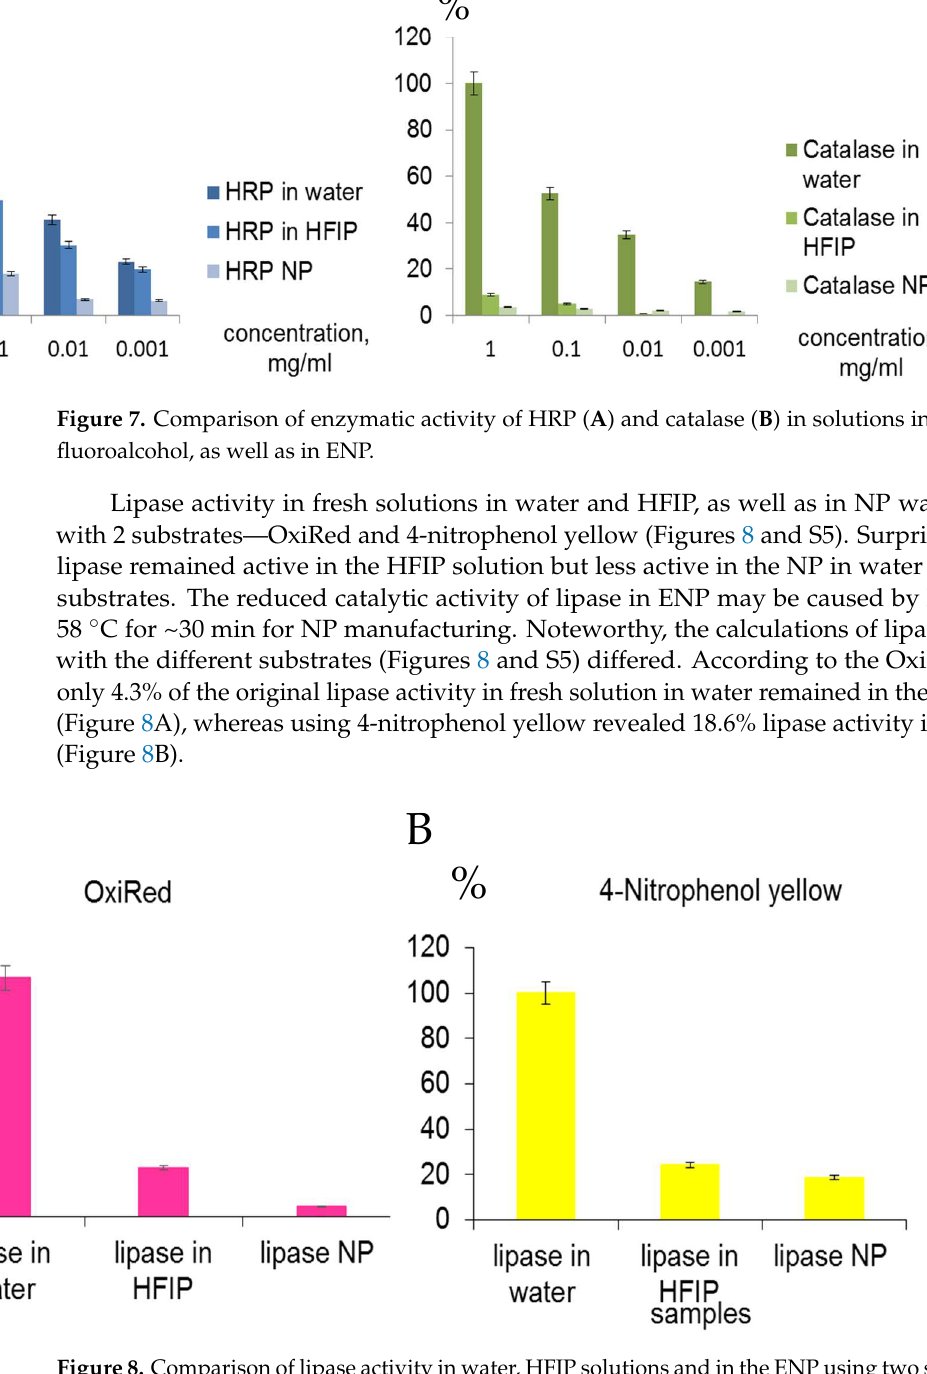
Figure 8. Comparison of lipase activity in water, HFIP solutions and in the ENP using two substrates—OxiRed dye by measurements of optical densities at 570 nm ( A ) and 4-nitrophenol yellow with spectrophotometric measurements at 410 nm ( B ).